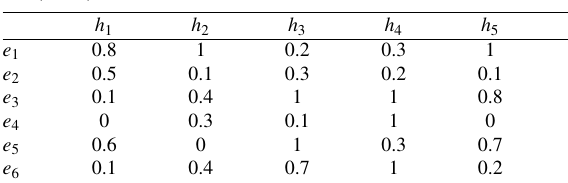
Table 1: Tabular representation of the fuzzy soft set ( F , A ) h